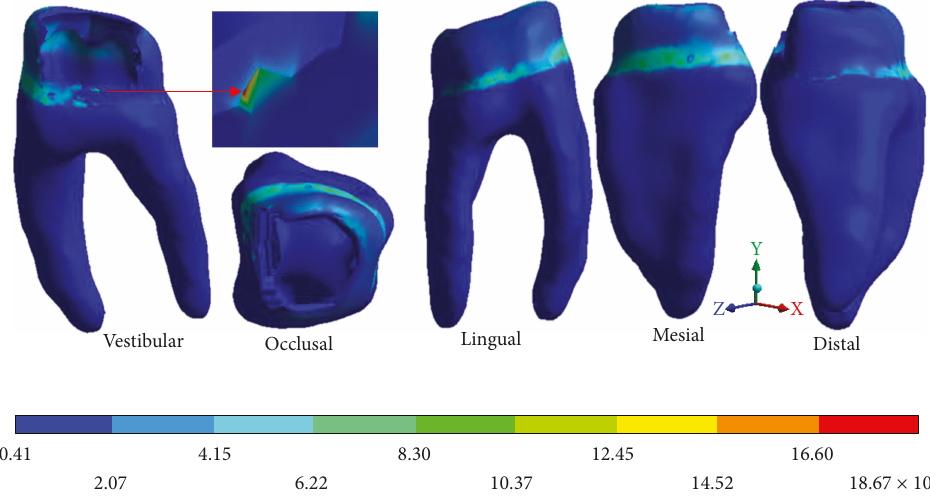
Figure 19: 4th degree caries : von Mises stresses in dentin.